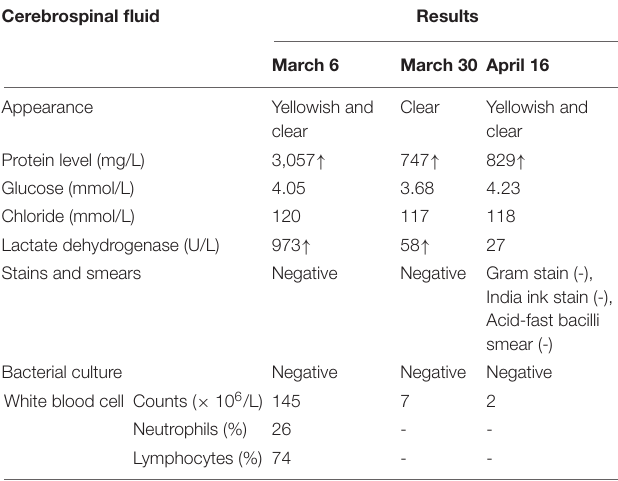
TABLE 1 | Lumbar puncture and CSF analysis